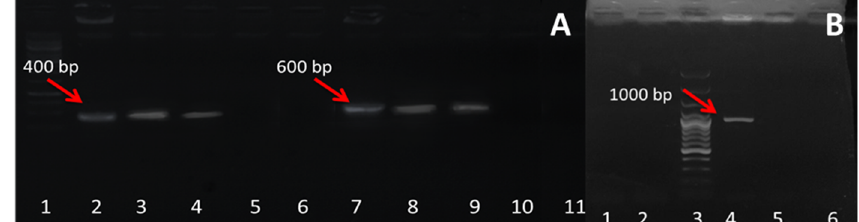
Figure 2. PCR detection of rolB , rolC , and virG . ( A ) PCR amplification of 400 bp fragments of rolB and 600 bp fragments of rolC . The detection of rolB : lane 1 = ladder 100 bp; lane 2 = positive control; lanes 3 and 4 = AHRs; lanes 5 and 6 = negative control of aeroponic roots. Detection of rolC : lane 7 = positive control; lanes 8 and 9 = AHRs; lanes 10 and 11 = negative control of aeroponic roots. ( B ) The absence of virG in AHRs: lanes 1 and 2 = negative control of aeroponic roots; lane 3 = ladder 1000 bp; lane 4 = positive control; lanes 5 and 6 = AHRs.